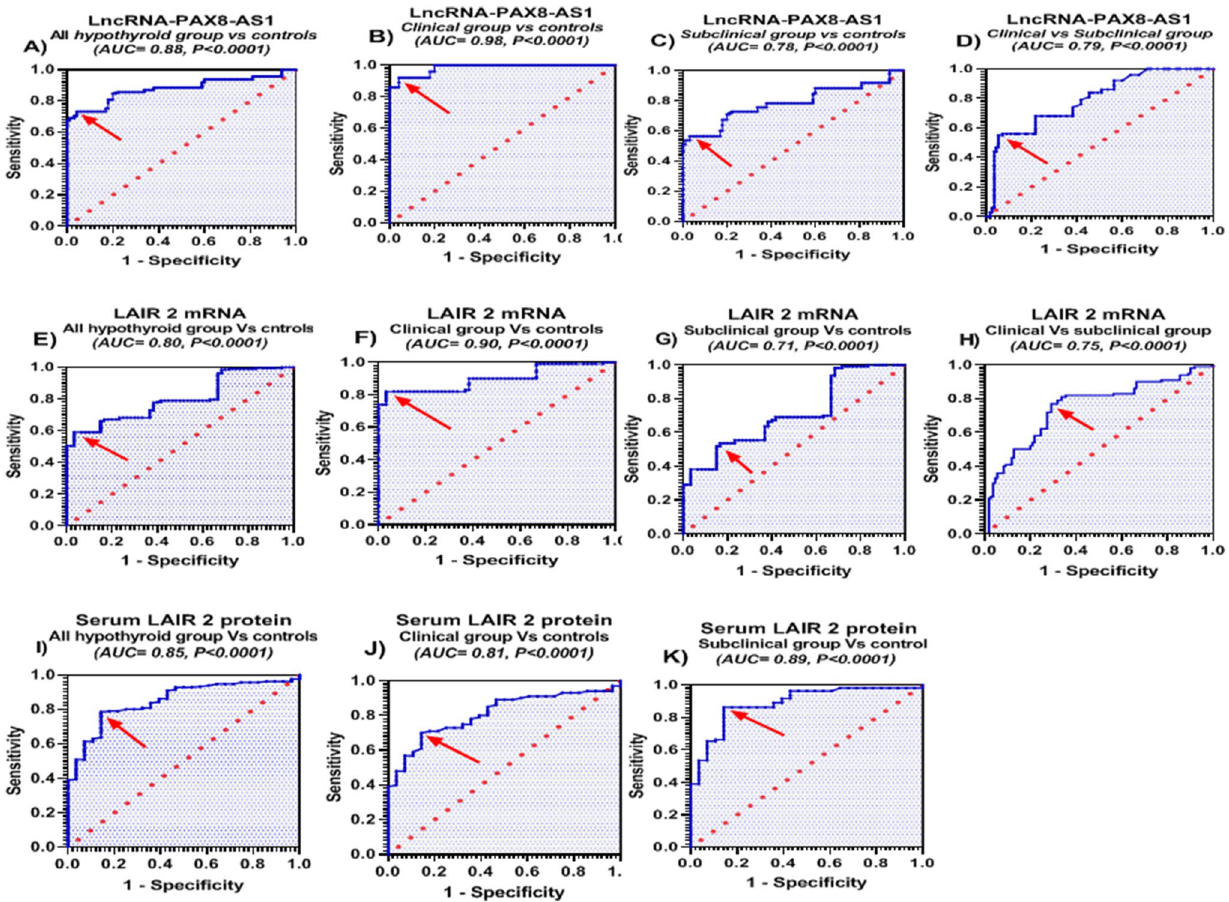
Figure 3. Diagnostic performance of serum lncRNA-PAX8-AS1, LAIR-2 mRNA and protein in studied groups using ROC curve analysis. Clinical hypothyroid group (n = 100), subclinical hypothyroid group (n = 110), all hypothyroid group (n = 210), and healthy controls (n = 95). The arrow points at the best cutoff point. P < 0.05 means statistical significance.